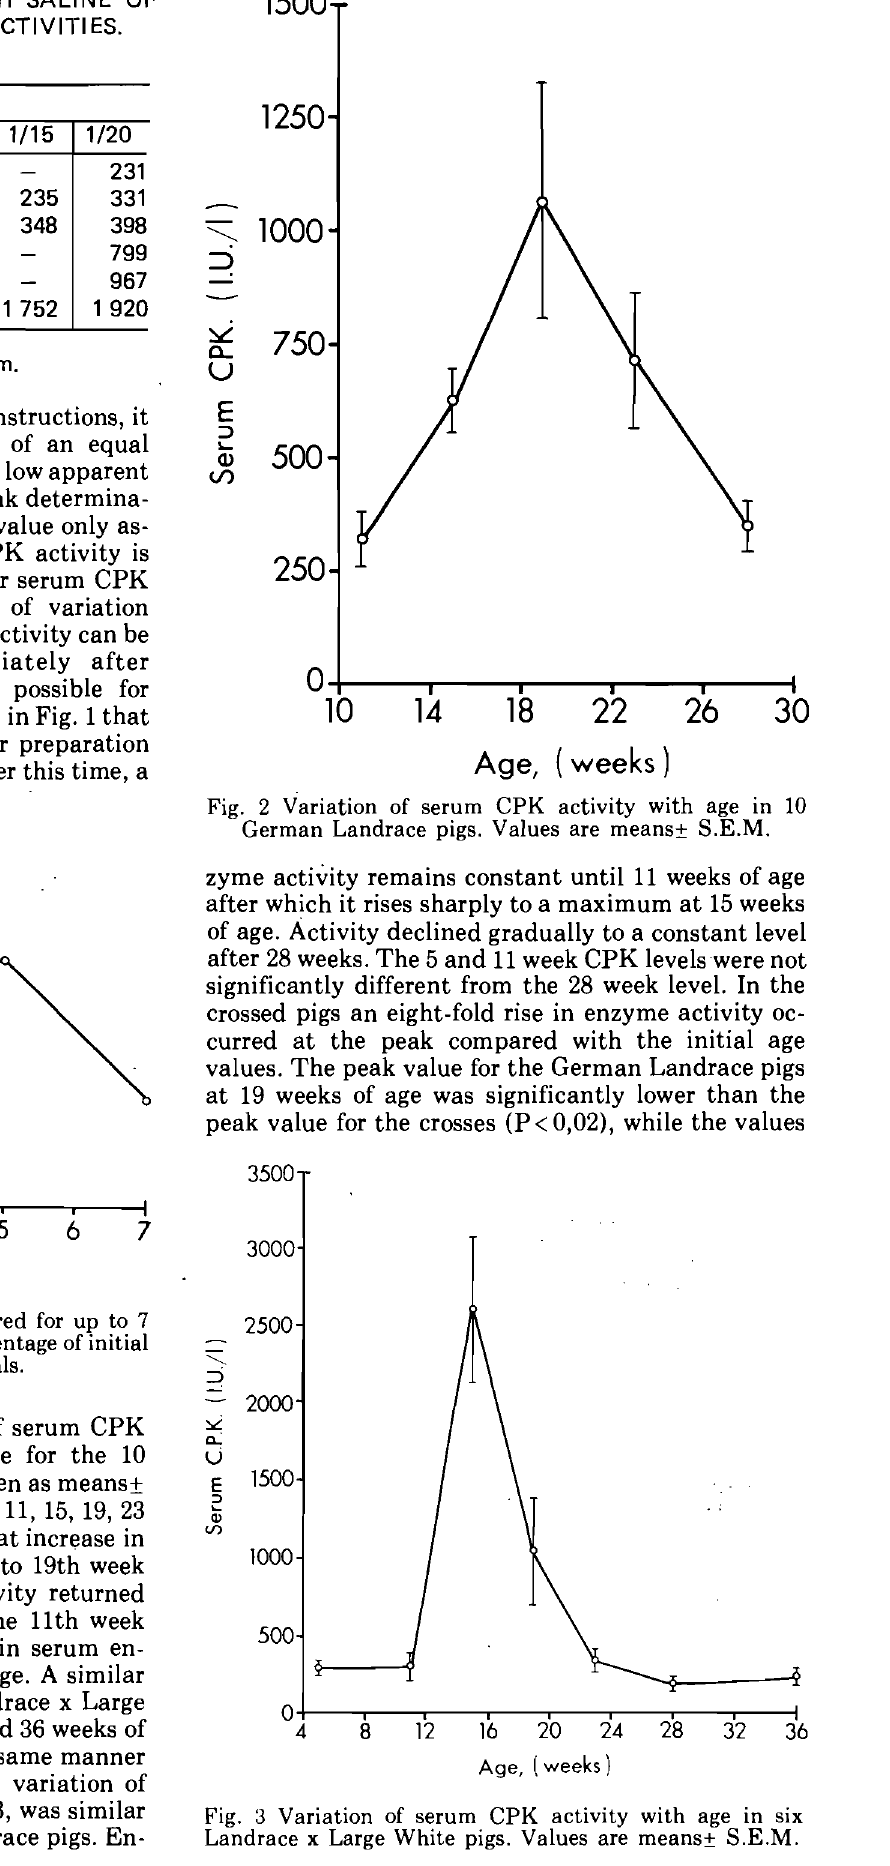
EFFECT OF DILUTION WITH SALINE OF SERA WITH LOW AND HIGH CPK ACTIVITIES.